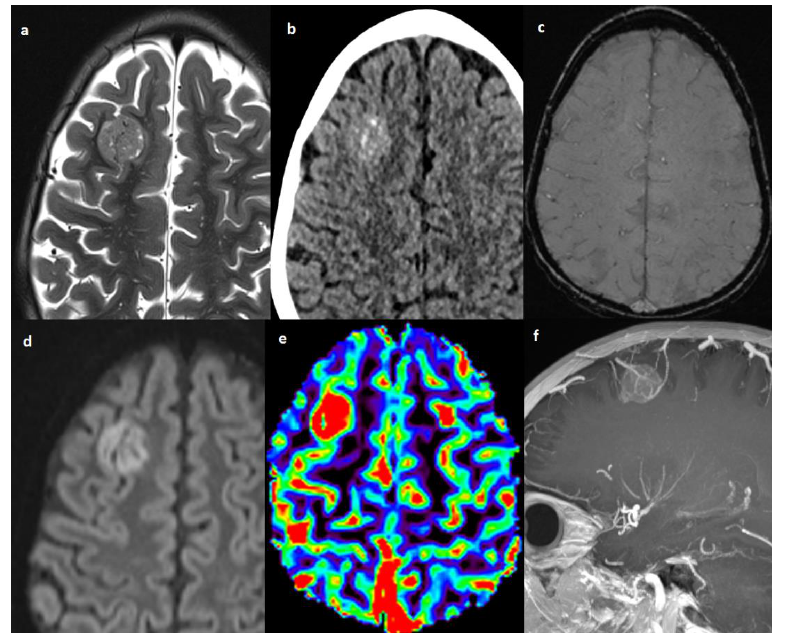
Figure 3. Patient #4 imaging features. Axial T2w image ( a ) shows a single lesion in the right frontal lobe, hyperdense on axial non contrast brain computed tomography (CT) ( b ), without hemorrhagic components in susceptibility weighted imaging (SWI) ( c ), but with restricted diffusion in diffusion weighted imaging (DWI) ( d ). The cerebral blood volume map from dynamic susceptibility contrast (DSC) perfusion images ( e ) shows elevated relative cerebral blood volume (rCBV) within the lesion consistent with angiogenesis/vascular proliferation. Post-contrast sagittal T1w image with maximum intensity projection (MIP) reconstruction ( f ) shows tortuous vessels within and around the